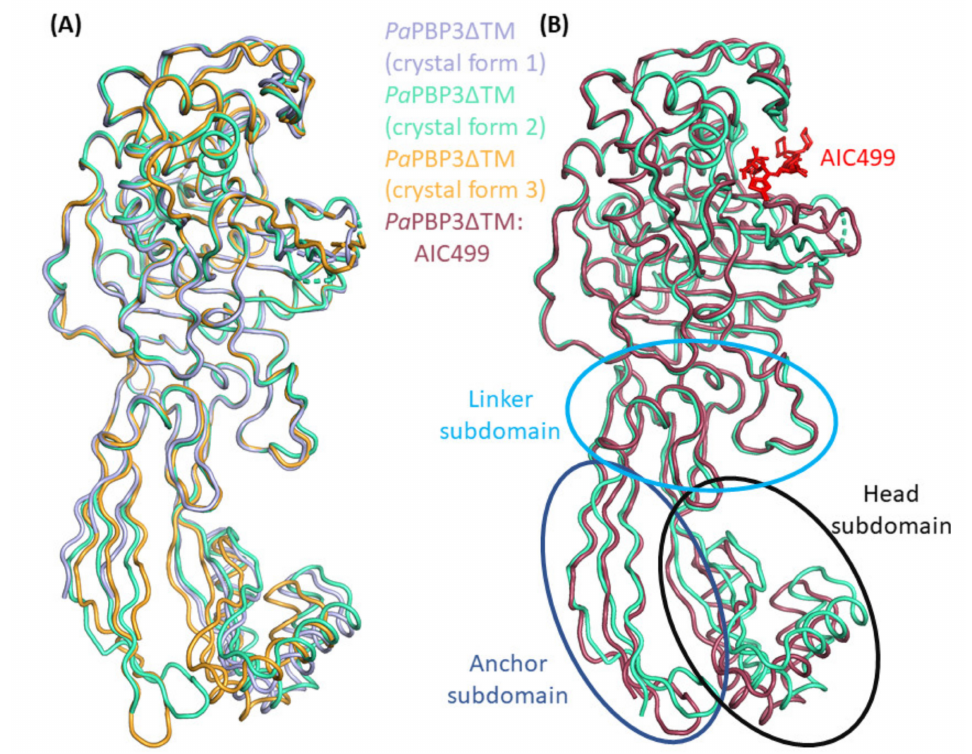
Figure 5. X-ray structures of Pa PBP3 determined in the absence and presence of AIC499 (red stick model). ( A ) Crystal form 1 (blue), crystal form 2 (green) and crystal form 3 (bright orange) of Pa PBP3 ∆ TM feature different unit cells, leading to slightly different orientations predominantly in the n-PBd. ( B ) The structure of apo- Pa PBP3 ∆ TM crystal form 2 (cyan) is used for superposition with Pa PBP3 ∆ TM:AIC499 chain B (dark red). Additionally, the head, anchor, and linker subdomains of the n-PBd are highlighted with black, dark blue, and light blue ellipses, respectively.